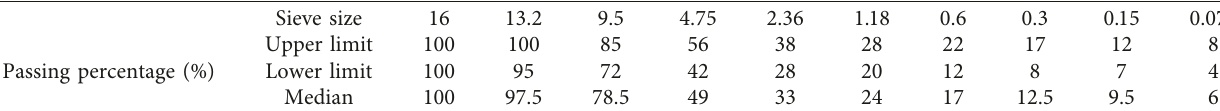
Table 2: Gradation of the asphalt mixture of AC-13.